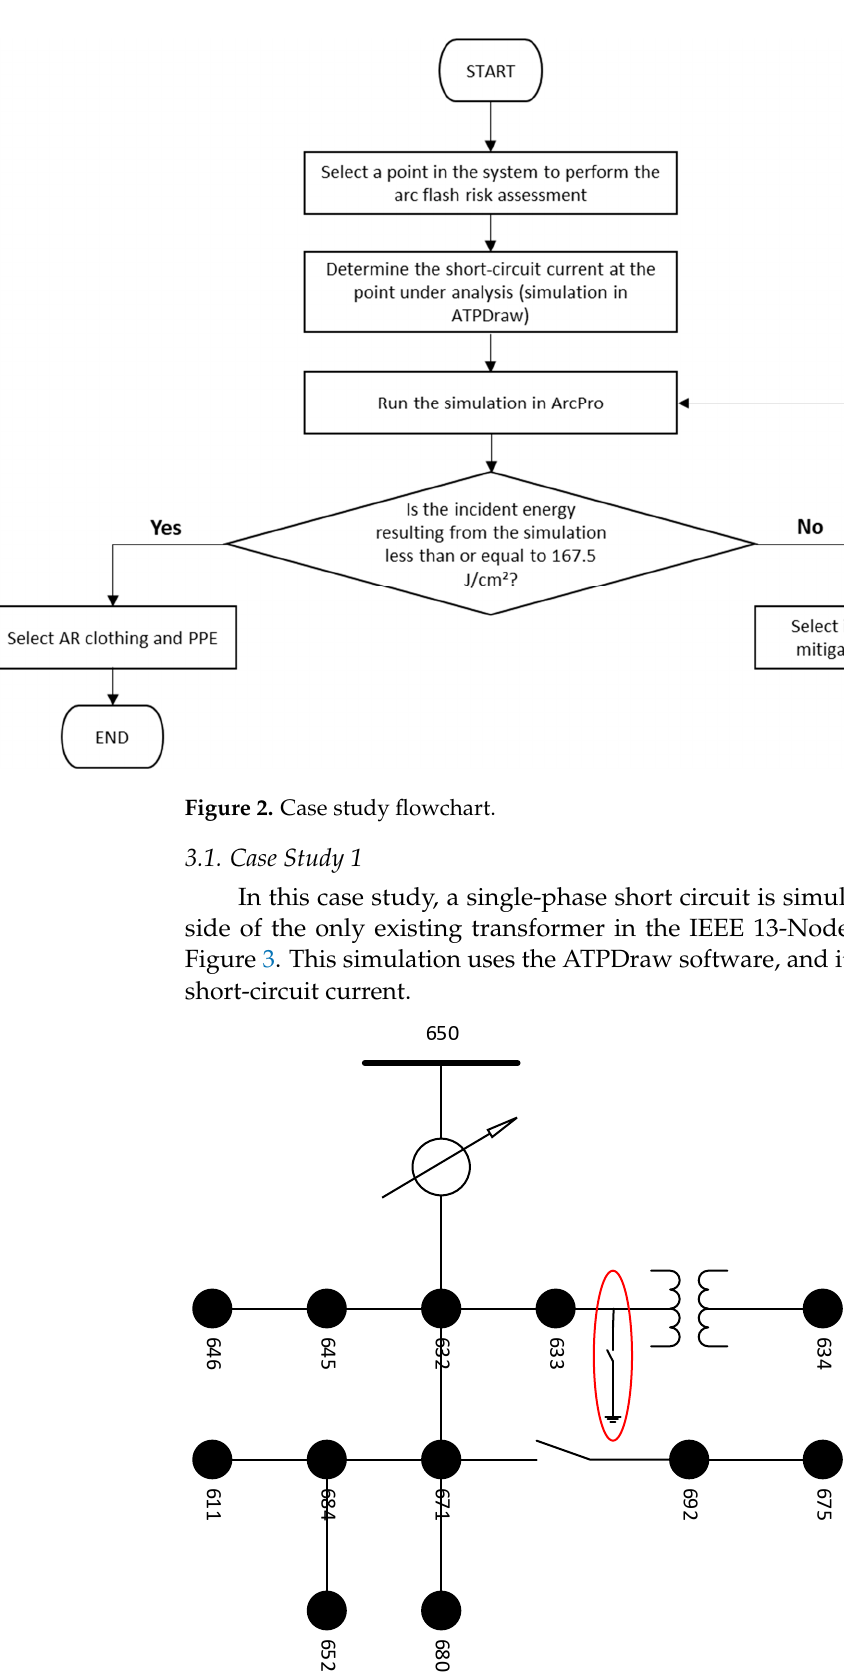
Figure 4. Data input screen for ArcPro simulation—Case study 1. Table 2. Relation of input data for ArcPro simulation—Case study 1. Input